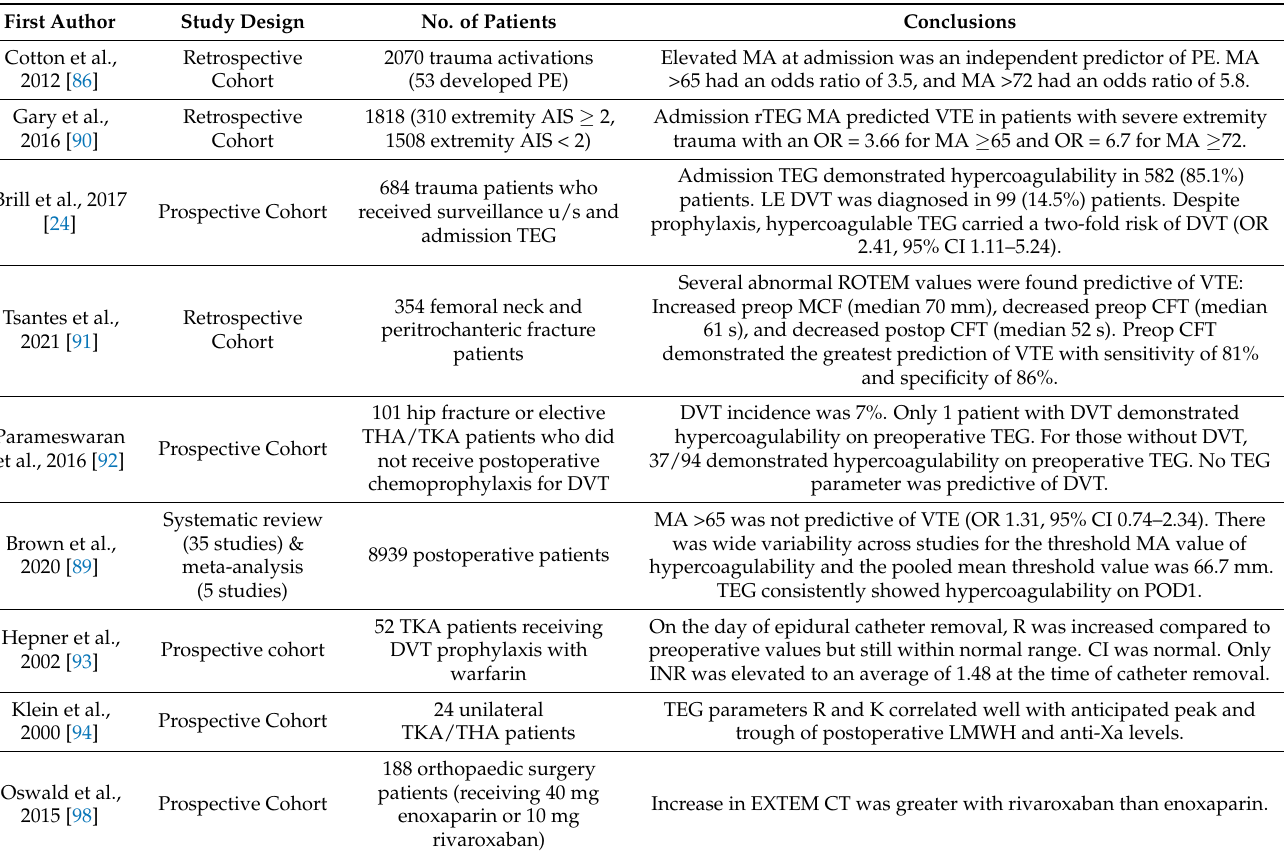
Table 8. Summary of the literature pertaining to viscoelastic hemostatic assays applied to the prediction and prevention of venous thromboembolism among orthopedic operative